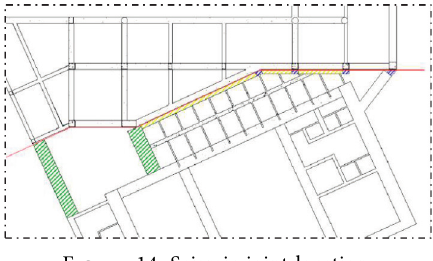
Figure 14: Seismic joint